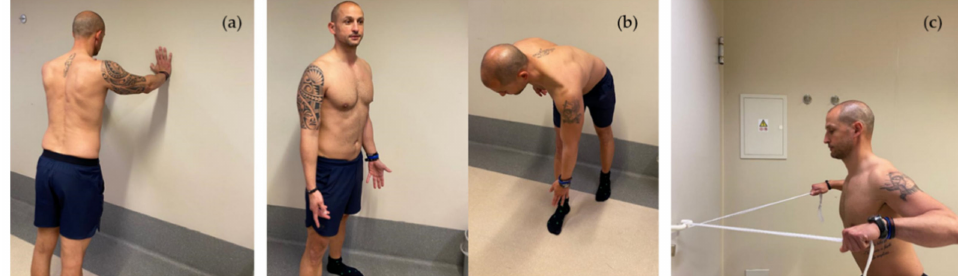
Figure 4. Representation of push up exercises ( a ), lawnmower exercises ( b ), and resisted scapular retraction ( c